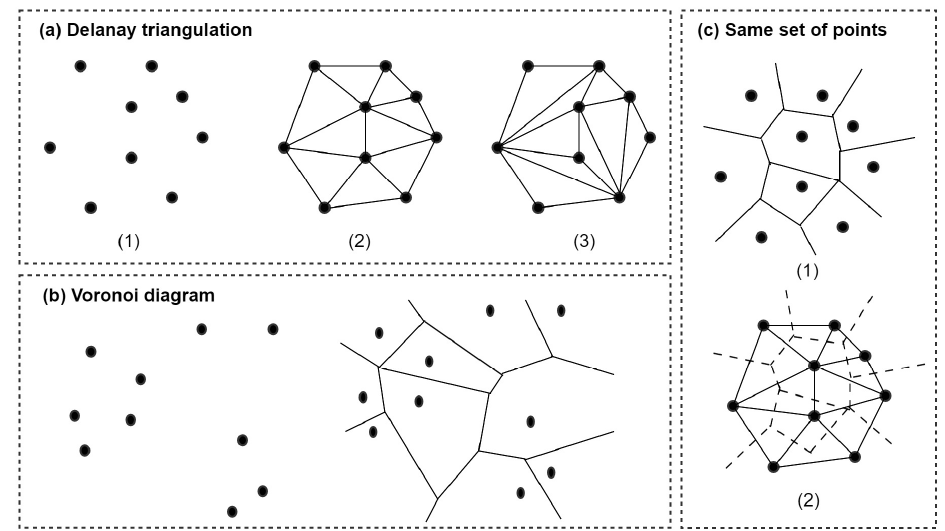
Figure 1. Delanay triangulation (DT) and the Voronoi diagram. ( a ) Delanay triangulation; ( b ) Voronoi diagram; ( c ) Same set of points.